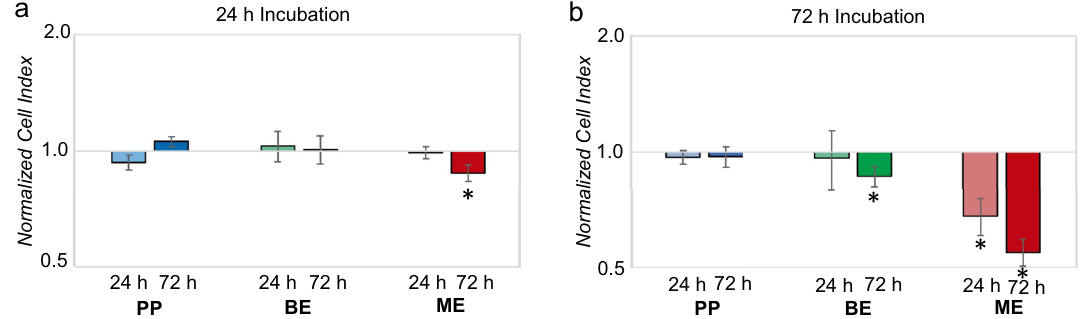
Figure 2. Impedance-based cell index normalized to the non-treated control group after exposure of HGK to eluates of the evaluated polymers (PP, BE, ME) for 24 h ( a ) and 72 h ( b ). The first column of each group represents the cell index after incubation with the 24 h eluate and the second column with the 72 h eluate.